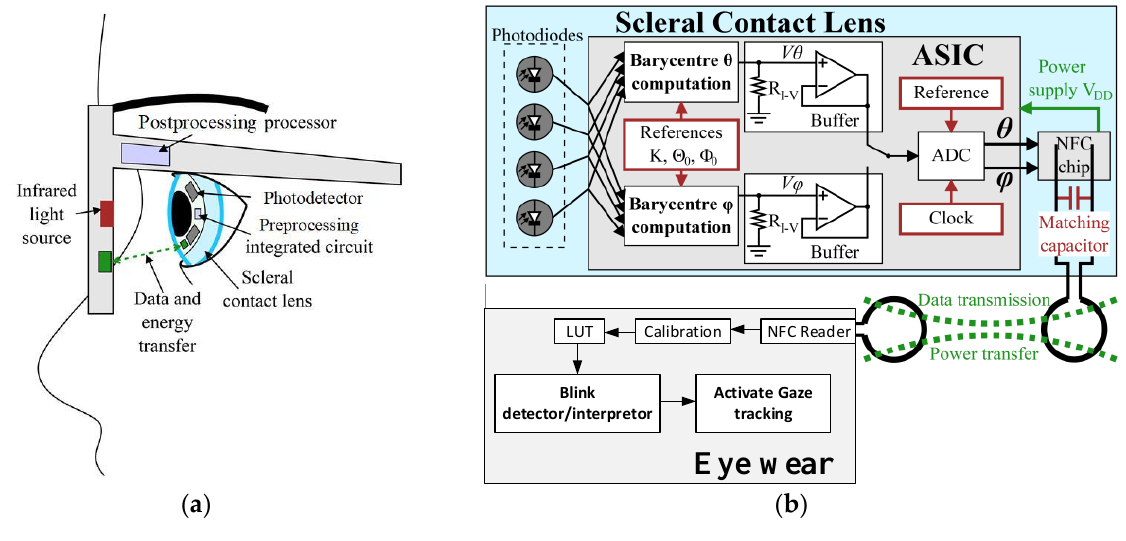
Figure 1. ( a ) Multifunction-instrumented SCL and its eyewear. An inductive link is used to trans- mit data and powers the SCL. ( b ) Block diagram of both elements; the eyewear performs data postprocessing to use blink as a HMI.